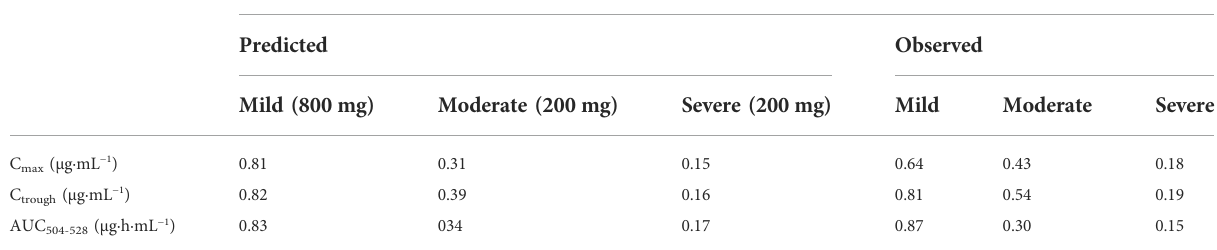
TABLE 7 PK variable (Median) ratios of PAZ in hepatic impairment patients.